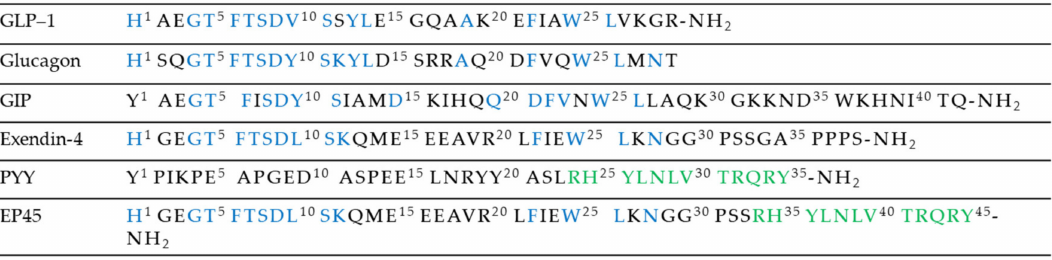
Figure 8. Sequence alignment of peptides Y2, EP45, glucagon, and incretin hormones.